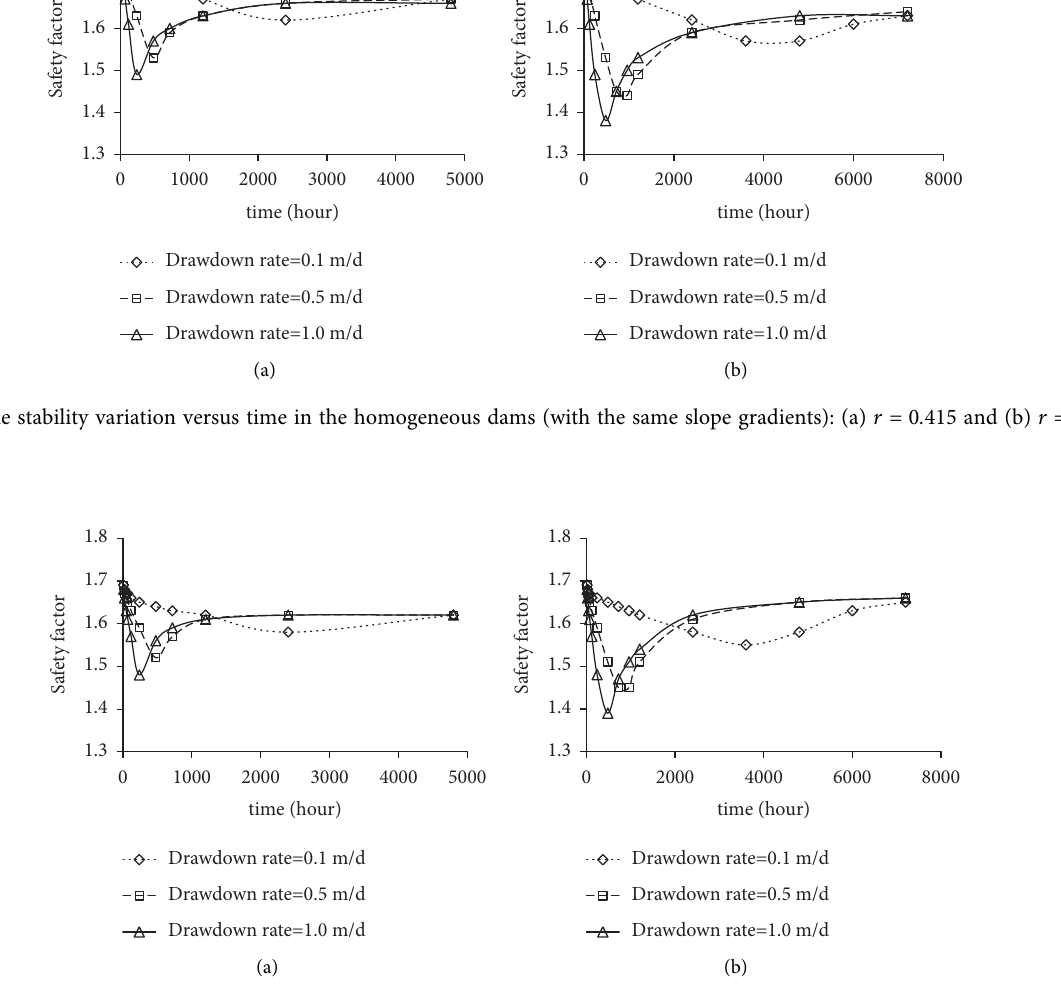
Figure 6: The stability variation versus time in the CCDs (with the same slope gradients): (a) r � 0 . 415 and (b) r � 0 .